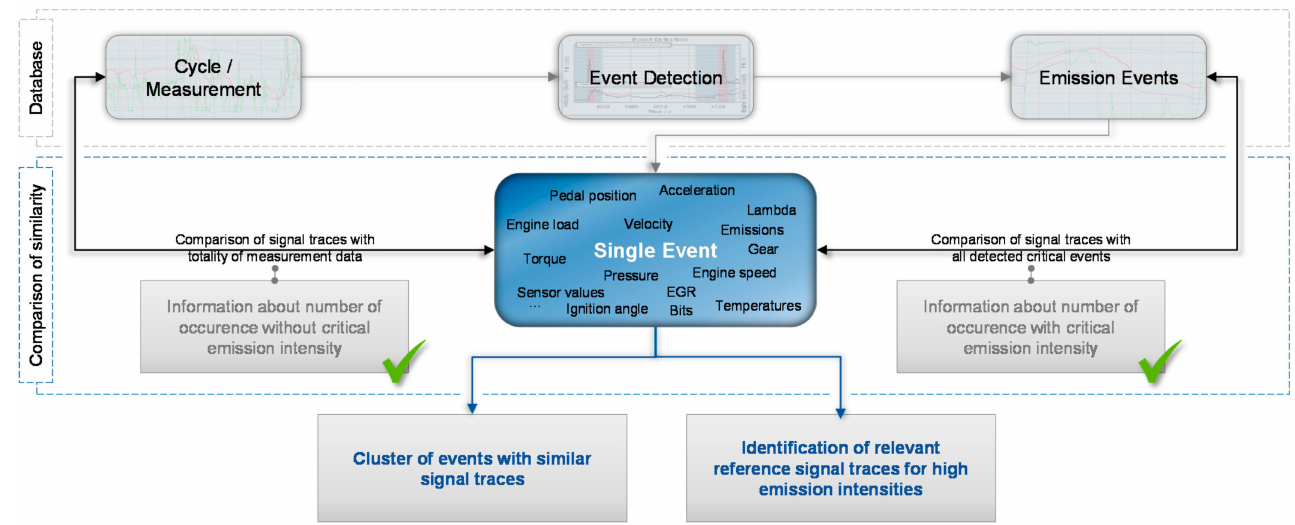
Figure 5. Schematical procedure for identification of critical signal patterns.